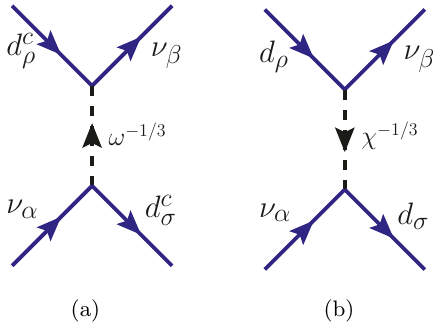
Figure 30 . Tree-level NSI diagrams with the exchange of heavy LQs: (a) for doublet LQ with Yukawa (cid:21) (1), and (b) for singlet LQ with Yukawa (cid:21) 0 (cid:24) O partial decay widths for ! (cid:0) 1 = 3